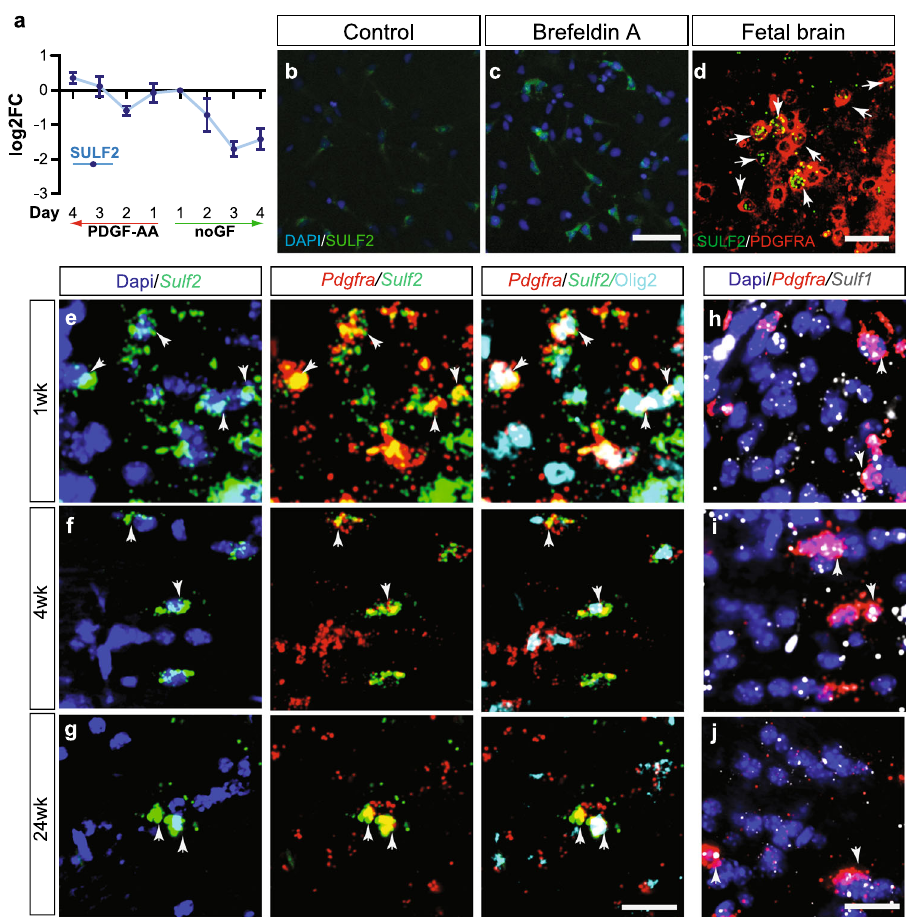
Fig. 1 Sulfatase is expressed by mouse and human OPCs. a RT-PCR analysis of SULF2 mRNA in human primary OPCs during in vitro differentiation with and without PDGF-AA removal (no GF) (mean ± SEM, n = 4 fetal samples). b , c , SULF2 protein (green) is expressed at low levels in hOPCs ( b ), and immunoreactivity substantially increased after treatment with the protein secretion inhibitor brefeldin A (5 µ g/ml) ( c ). Confocal micrograph of SULF2 mRNA (green)-expressing PDGFRA + OPCs (red) in fetal human brain ( d ). e – g Sulf1 and Sulf2 expression was analyzed by confocal microscopy in mouse corpus callosum during normal development by RNAscope in situ hybridization and combined with Olig2 immunohistochemistry (IHC) at postnatal day 7 ( e , h ), day 28 ( f , i ) and at 24 weeks ( g , j ). DAPI (blue), Sulf1 mRNA (gray), Sulf2 mRNA (green), Pdgfra mRNA (red), and Olig2 protein (cyan). White arrows denote Pdgfra + OPCs expressing Sulf1 and Sulf2 . Scale: 100 µ m ( b , c ), 20 µ m ( d ), and 20 µ m ( e – j